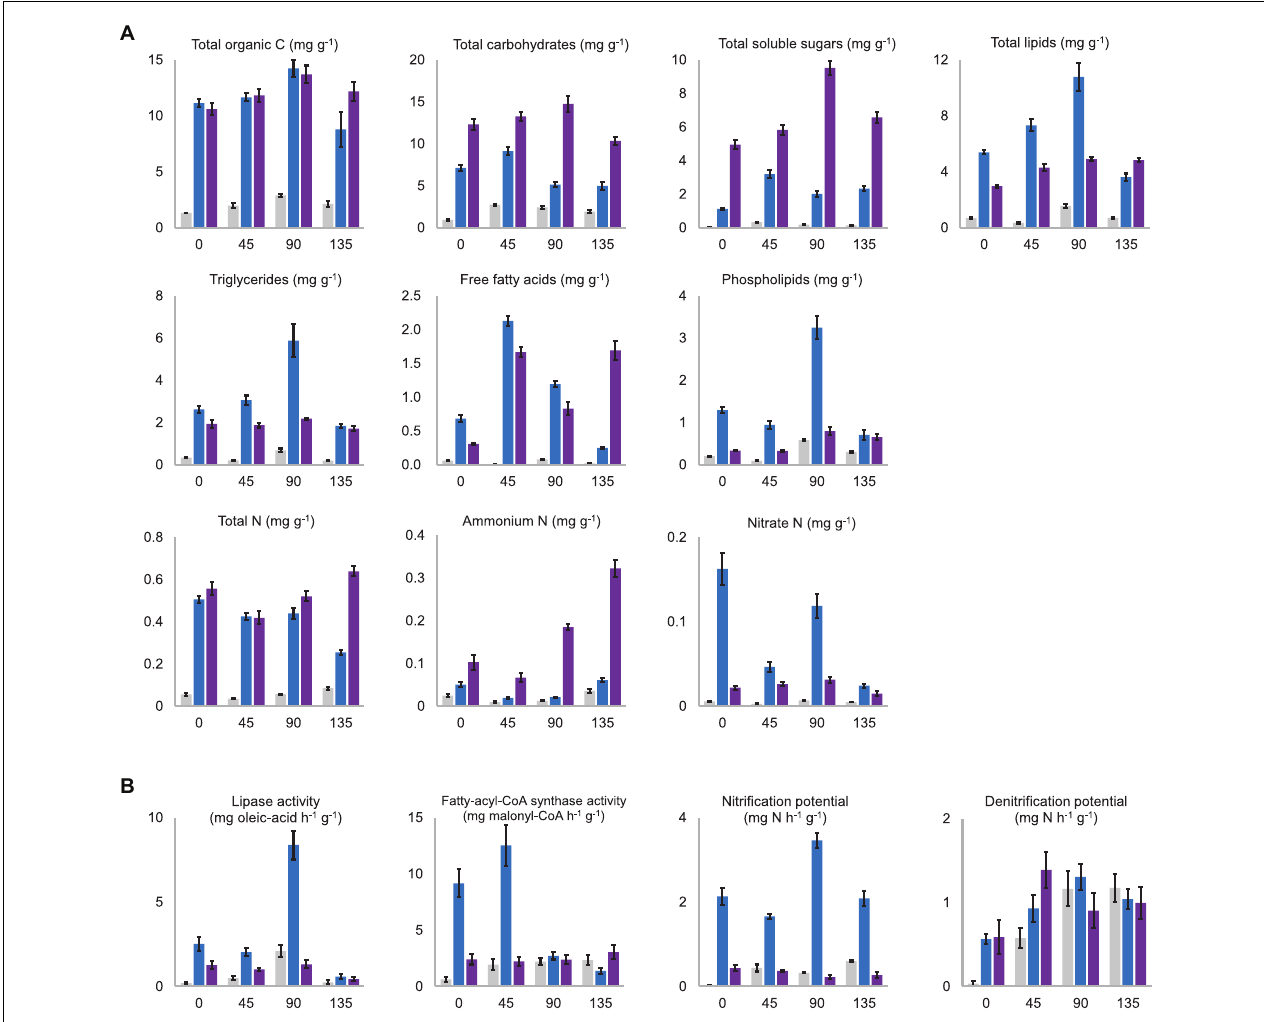
FIGURE 5 | (A) Contents of the major nutritional substances which were significantly differentiated among the substrata. NC, C1, and C2 were colored in gray, blue, and purple, respectively. All the presented values are the mean of three biological replicates with standard deviation bars. The horizontal axis in all charts means days after morel sowing. A complete version of this figure showing all the nutritional substances determined in this study is provided in the Supplementary Figure 7 . (B) Activity levels of key enzymes for C and N metabolism, which were significantly differentiated among the substrata. The activity level was shown as the catalytic ability to transform one milligram of the assay-substrate per hour by one gram (dry weight) of the substratum. A complete version of this figure showing all the activities measured in this study is provided in the Supplementary Figure 8 .